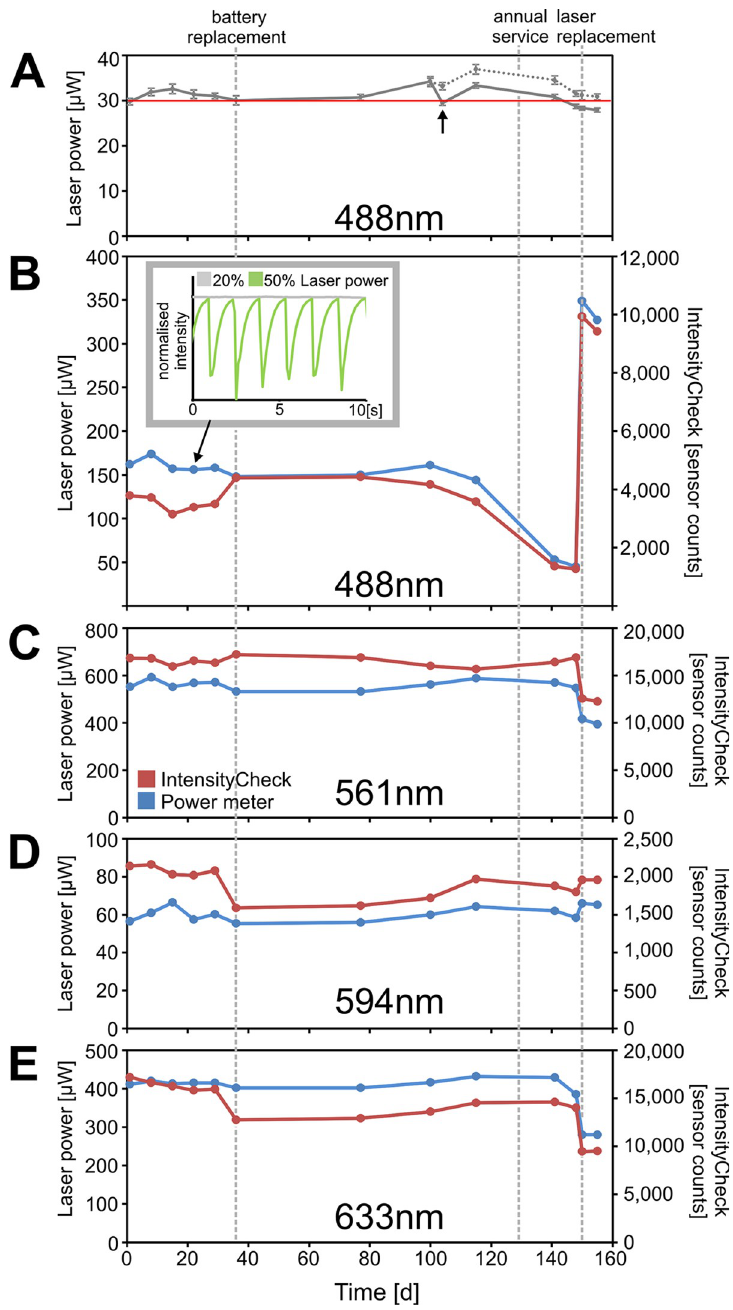
Fig 6. Long-term laser power measurements using IntensityCheck. (A) IntensityCheck was used to maintain an arbitrary sample illumination intensity of 30 μ W (488 nm) despite the large variations in laser output shown in (B). Recalibration was required after battery replacement (changing IntensityCheck target value from 680 to 910), and again after the actual laser power had changed by more than 10% (arrow). The dotted line shows the laser power if the second recalibration had not been carried out. (B) At the same time points IntensityCheck readings were compared to the actual laser meter readings measured in the sample plane of a confocal microscope (488nm line of the Argon laser, laser power level: 20%; AOTF: 25%; TSL2561 light sensor). IntensityCheck followed the measured laser output well, except for a sudden change when the device was removed from the objective turret for battery replacement, probably slightly displacing or tilting the sensor in the process compared to the previous time points. The inset shows IntensityCheck recordings taken at the indicated timepoint (arrow) with abnormal laser oscillations at high tube current indicative of an aging gas laser that eventually failed requiring replacement. (C-E)